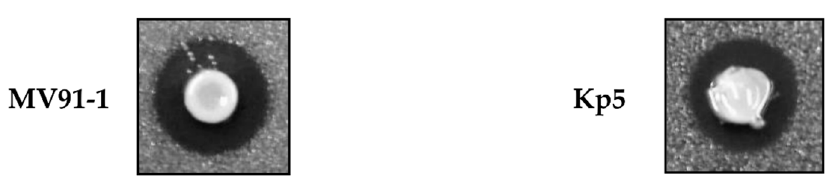
Figure 4. Antimicrobial activity of K. pneumoniae MV91-1 (commensal) and Kp5 (community-acquired) against K. pneumoniae K12-9, a multidrug ESBL-producer isolate from NICU.